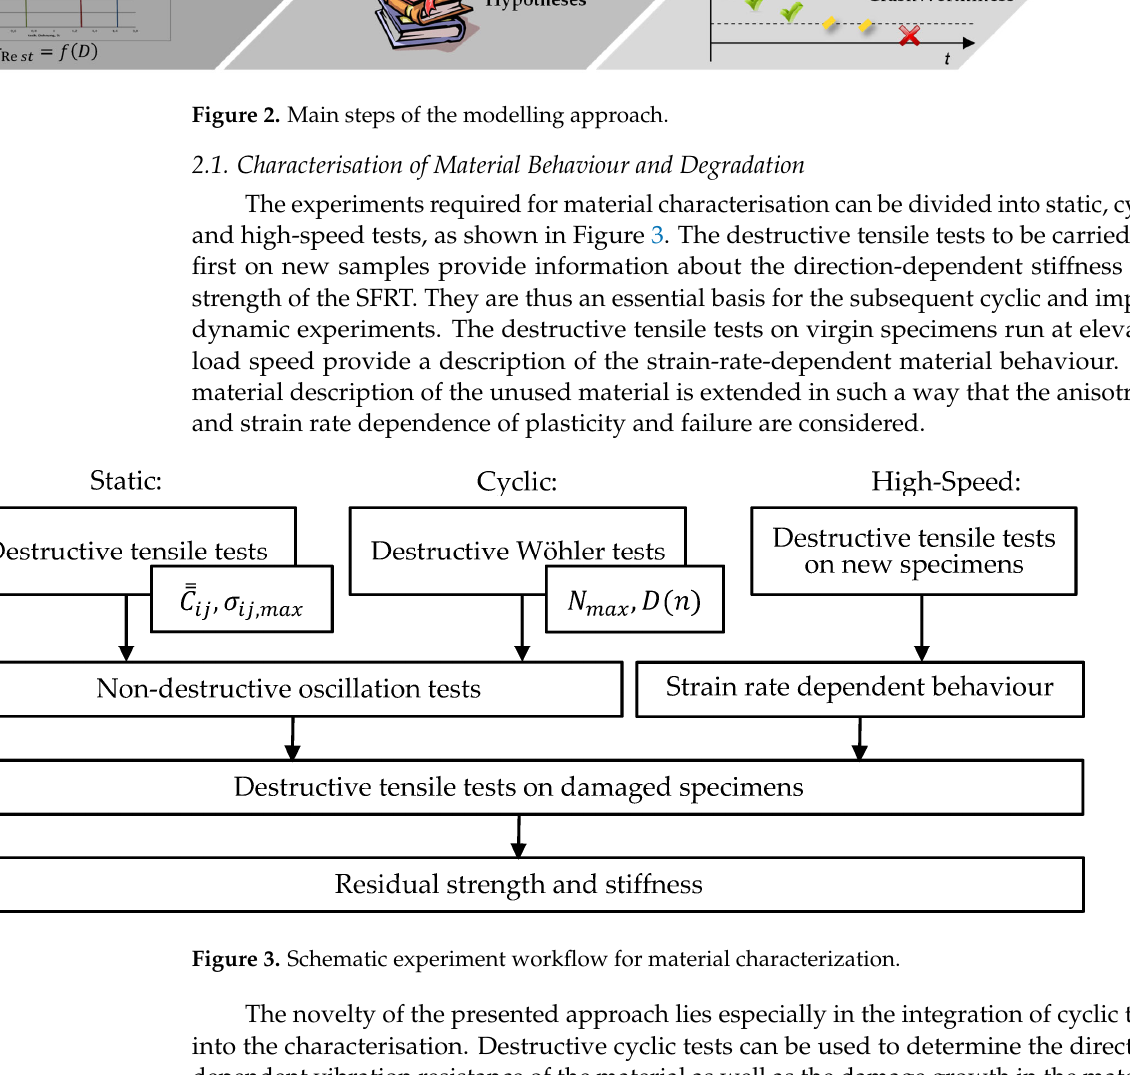
Figure 3. Schematic experiment workflow for material characterization.